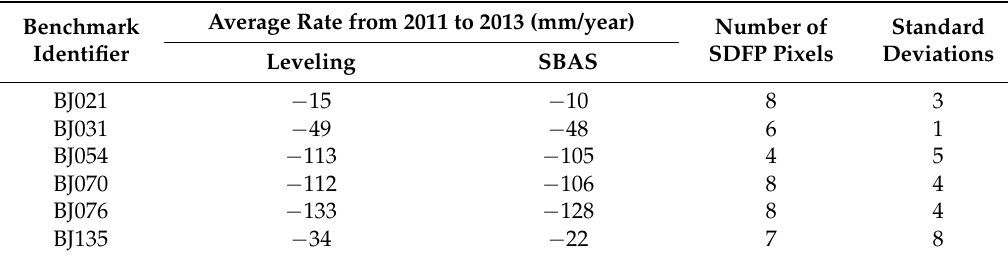
Table 1. Comparisons of annual average land subsidence rate (mm/year) between SBAS-derived results and ground leveling data at the 6 benchmarks. SDFP: single-look slowly-decorrelating filtered phase.